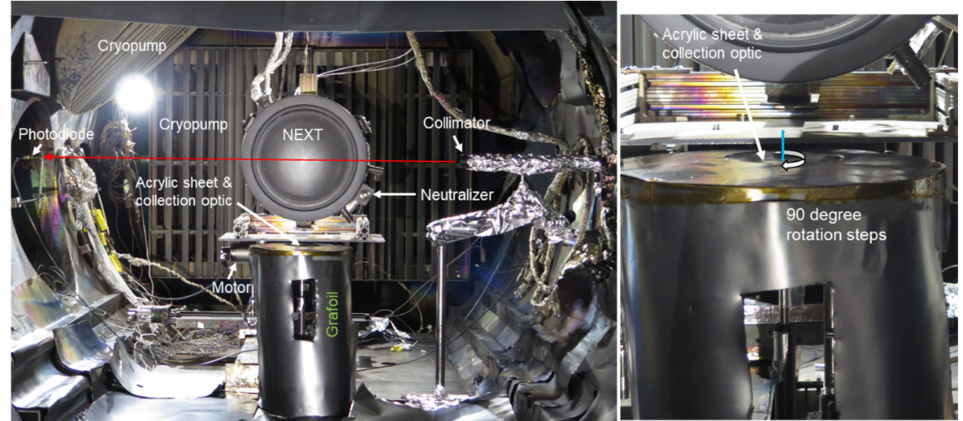
Figure 2. Photo of set-up inside the vacuum chamber ( left ), with magnified view of collection optic assembly ( right ).